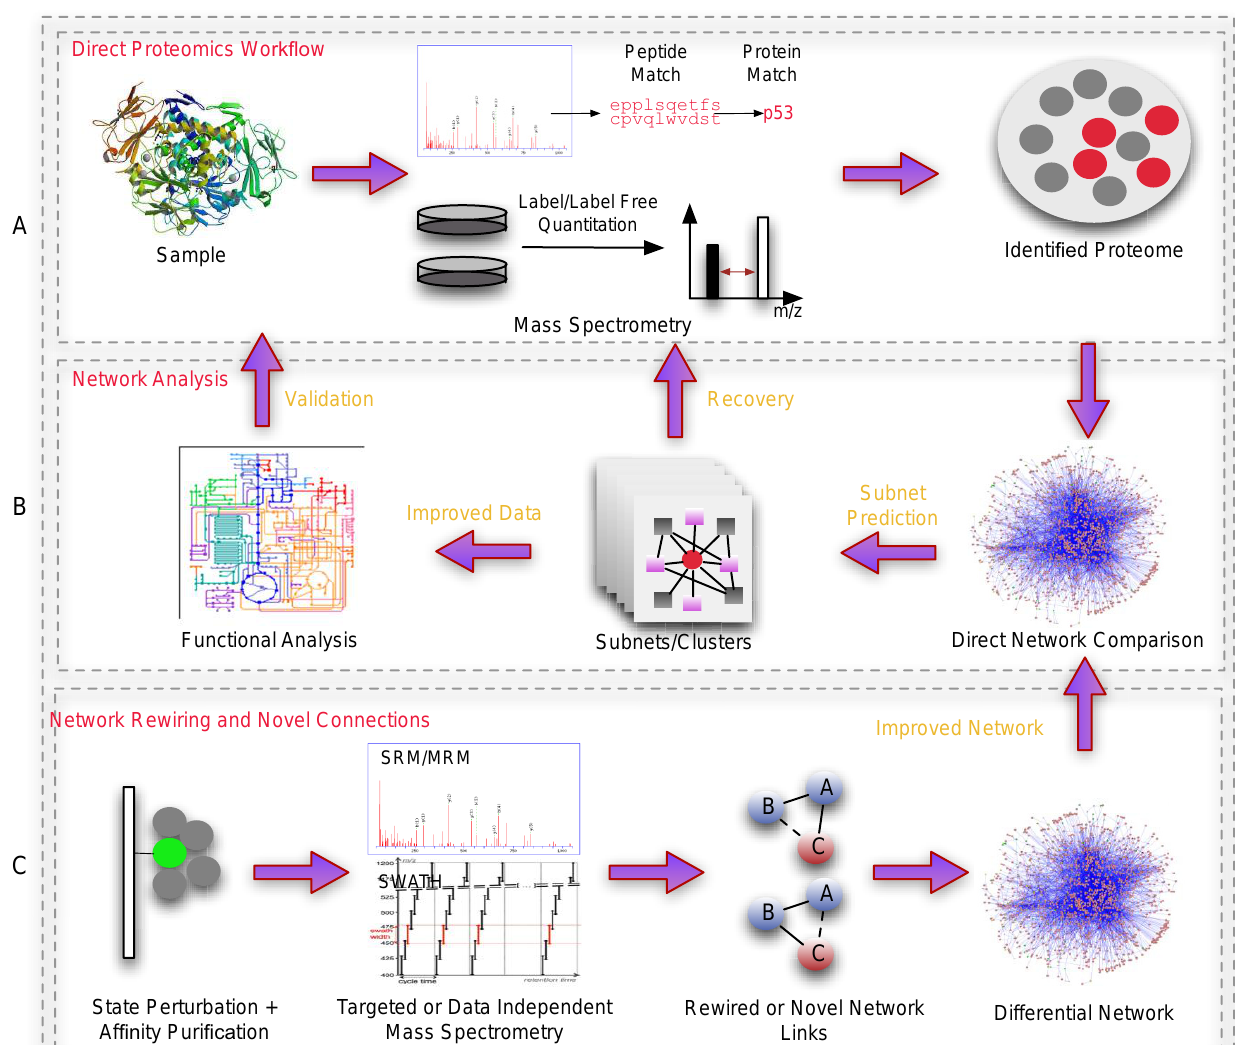
Figure 2. An overview outlining a general workflow using networks in proteomics. Panel A is a simple depiction of sample preparation and proteomic processing, producing a list of identified/quantified proteins. This data set normally suffers from inconsistency and coverage issues (if performed via shot-gun methods) which is difficult to analyze effectively. Panel B depicts a simple subnet-based workflow where dysregulated proteins (red) are mapped onto a network, and used to predict novel clusters. These novel clusters would consist of undetected proteins which can be re-checked (Recovery) against the original mass spectra (peptide-spectra matches that did not meet the filtering requirements). Alternatively, recovery can also be achieved via the use of SRM/MRM proteomics (not indicated). The improved data set (with expanded set of proteins), in their respective clusters (biologically contextualized) can be deployed for functional analyses. Panel C shows an example of how proteomics can improve the reference network. Here, affinity purification coupled to proteomics-based direct monitoring methods can be used to identify state-specific rewiring events or novel interactions between proteins under various conditions. These in turn, can be used to build more accurate/higher quality reference networks for biological